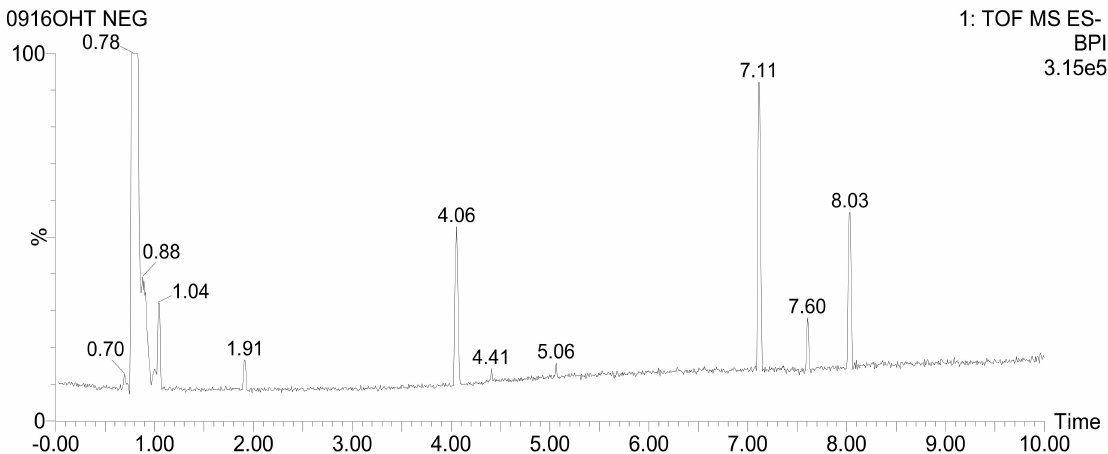
Figure 5. UPLC-QTOF-MS chromatogram of putatively identified compounds from ethyl acetate fraction of H. tuberosus . RT at 1.04 min: fructosylnystose, 1.91 min: chlorogenic acid, 4.06 min: dicaffeoylquinic acid isomer1, 4.41 min: dicaffeoylquinic acid isomer2, 7.11 and 7.60 min: unknown, 8.03 min: pinellic